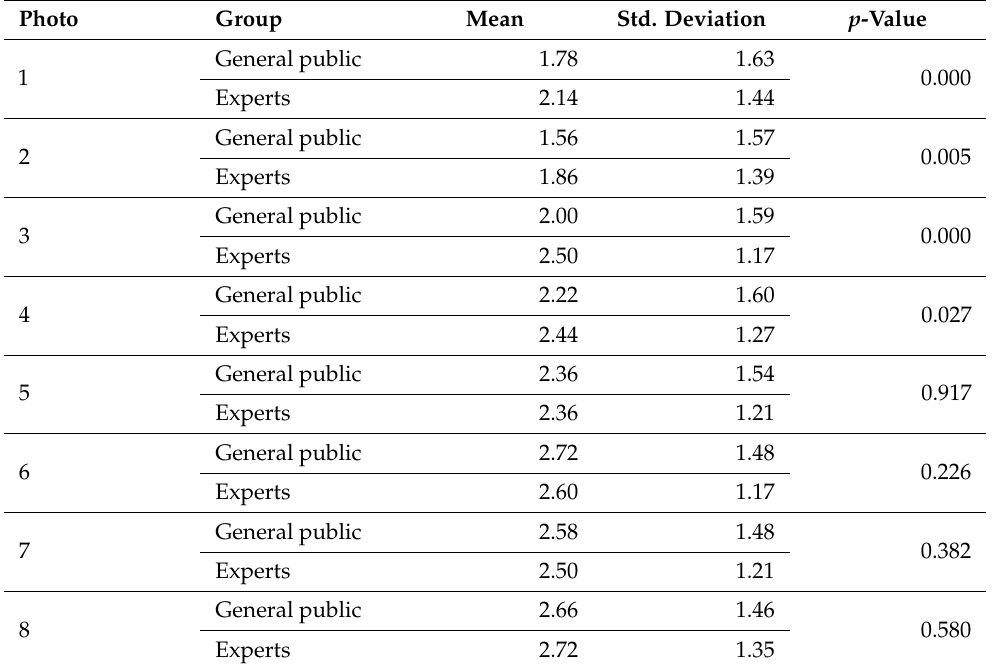
Table 18. Evaluation of each context by experts and the public. Photo